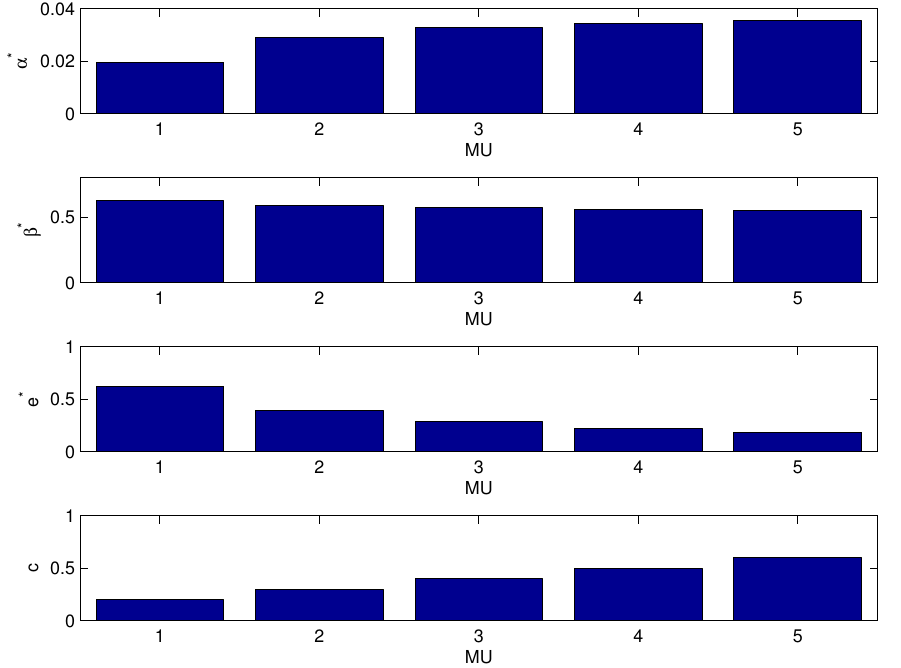
Figure 5. Mobile users’ (MUs’) optimal contract design with the crowdsourcing cost coefficient c i for fixed η M = 0.3, η S = 0.3, σ 2 = 1, θ i = 0.2, and ¯ U = 0.